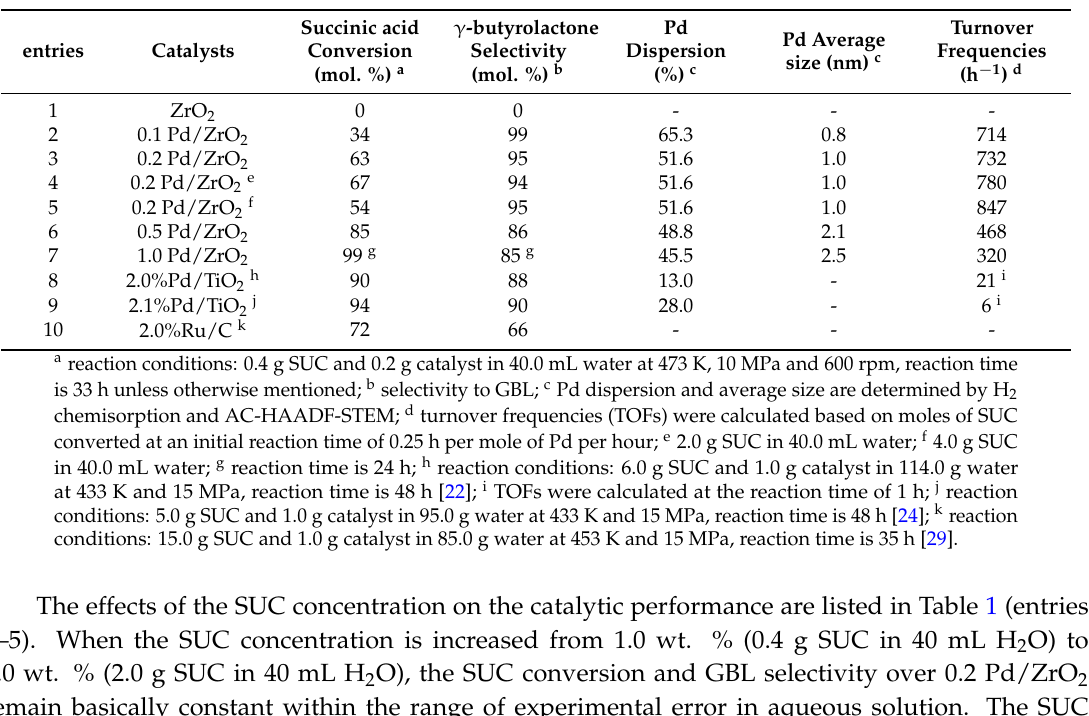
Table 1. Catalytic activity of Pd/ZrO 2 and reported Pd catalysts for the hydrogenation of succinic